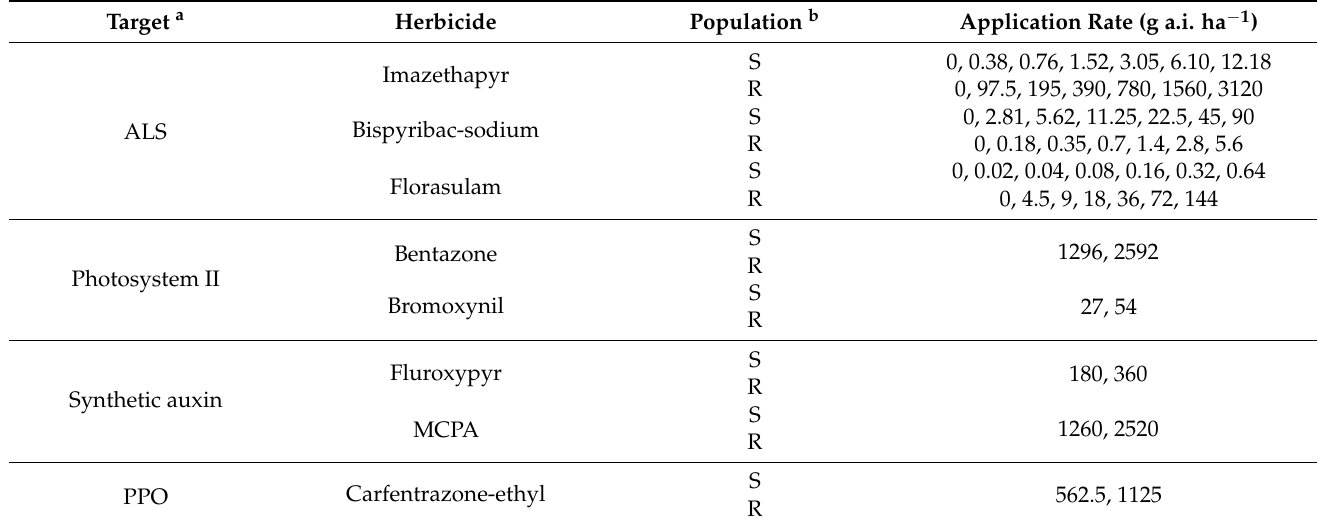
Table 6. Information on herbicides used in cross resistance and multiple resistance